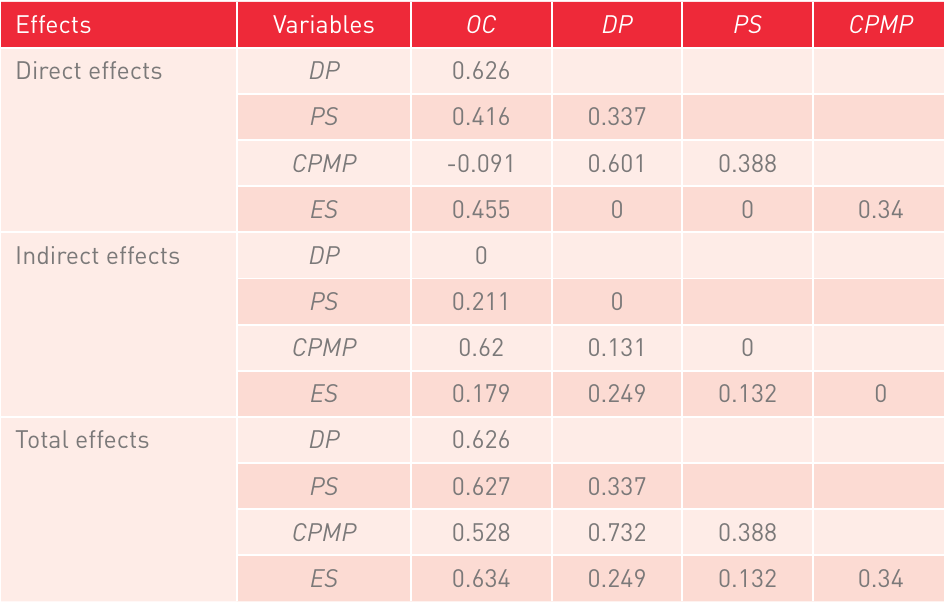
Standardized direct/indirect/total